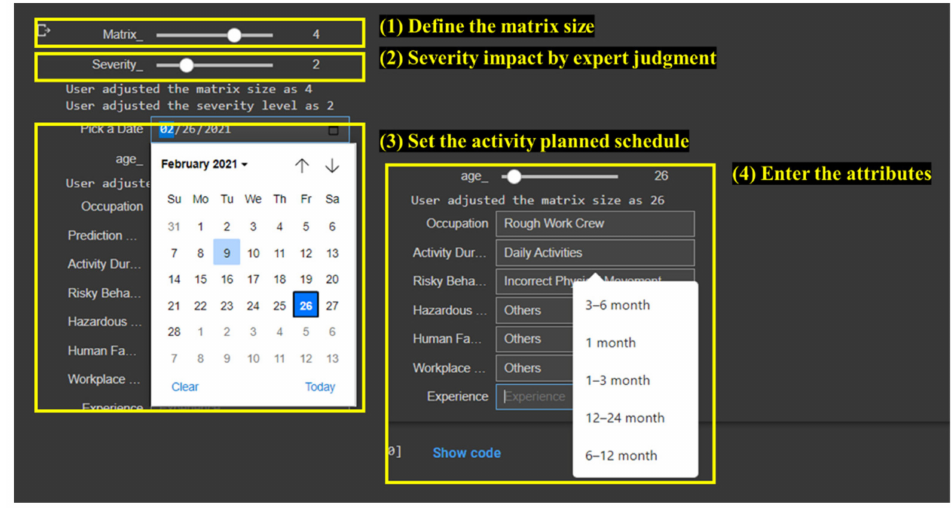
Figure 9. User input for requesting a severity prediction for a particular event outcome.